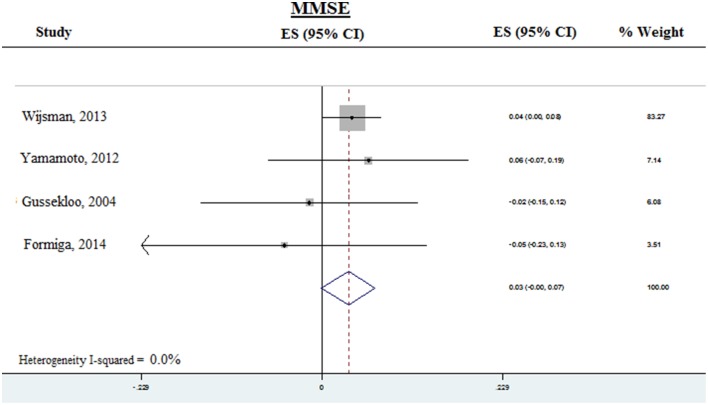
Forest plots depicting the prospective analysis of associations observed between subclinical hypothyroidism and decline in global cognition as measured by MMSE, arranged according to the weight of the studies. The pooled effect sizes are displayed as diamonds. MMSE, Mini-mental state examination.